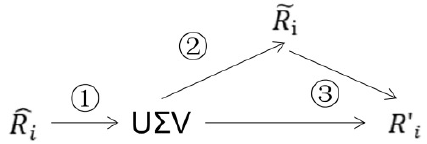
Figure 4. Rotation matrix corrector